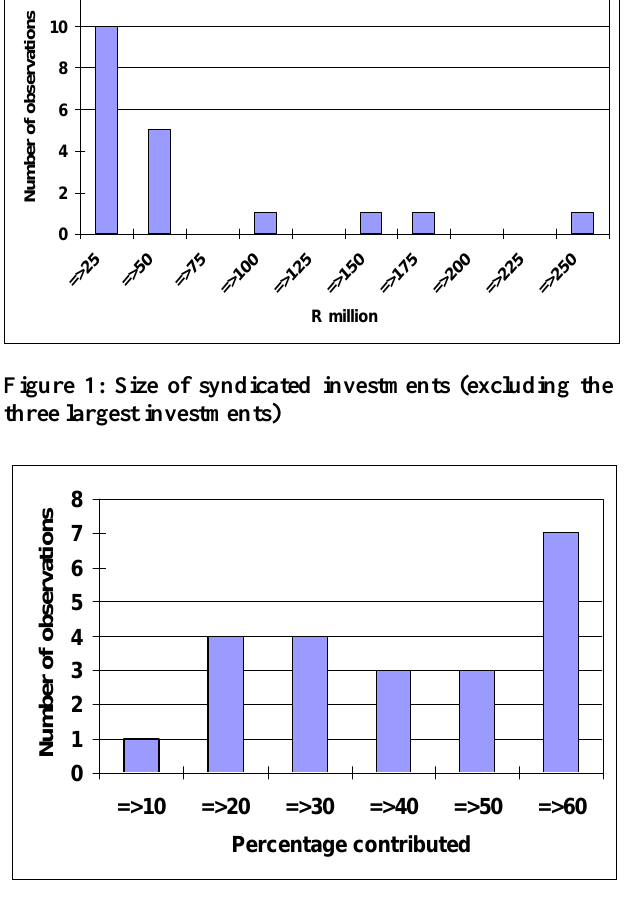
Figure 2: Distribution of percentage contributed in each syndicated